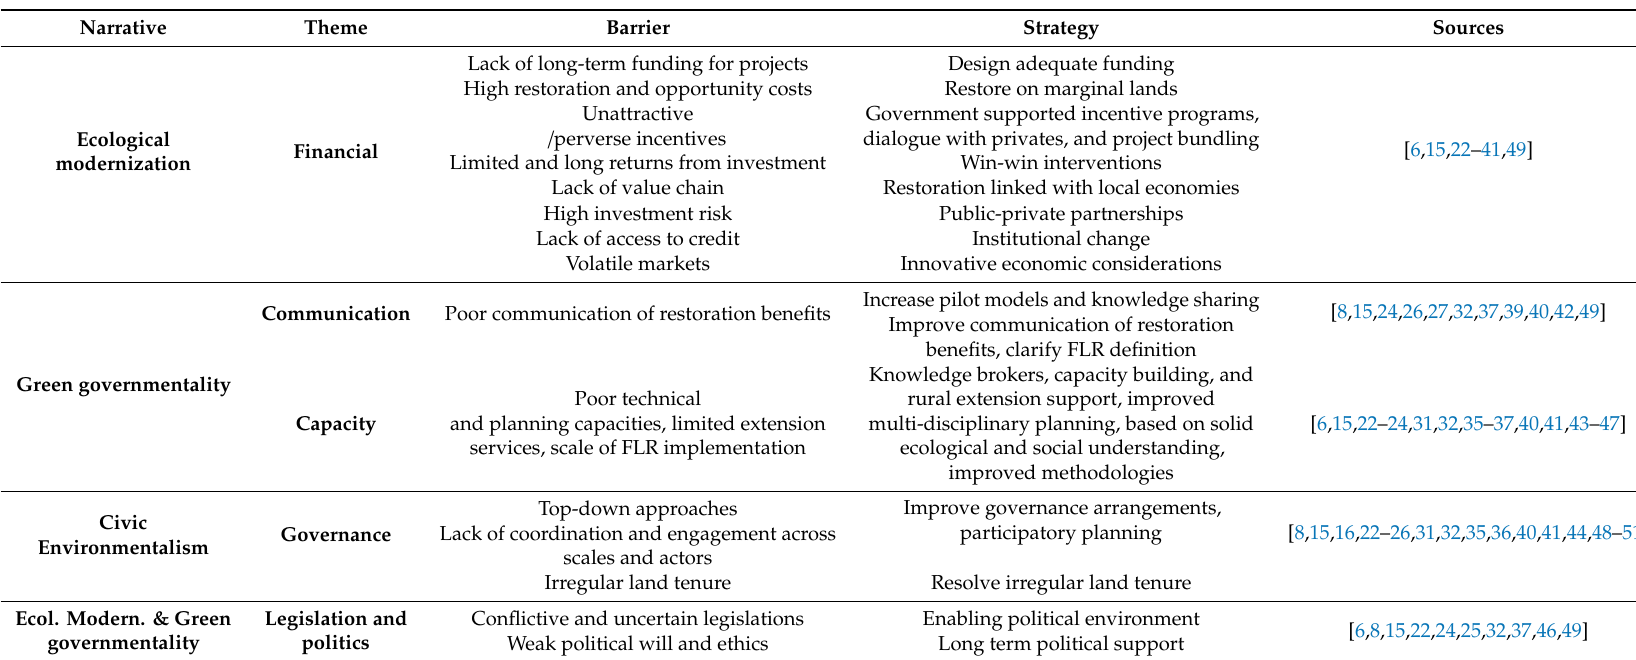
Table 1. Summary on barriers and strategies to Forest and Landscape Restoration (FLR) implementation mentioned in the global